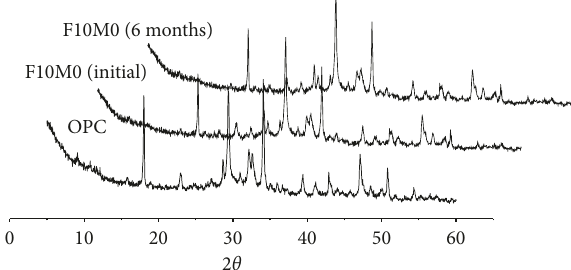
Figure 3: XRD graph for the semi premix paste after 28 days.